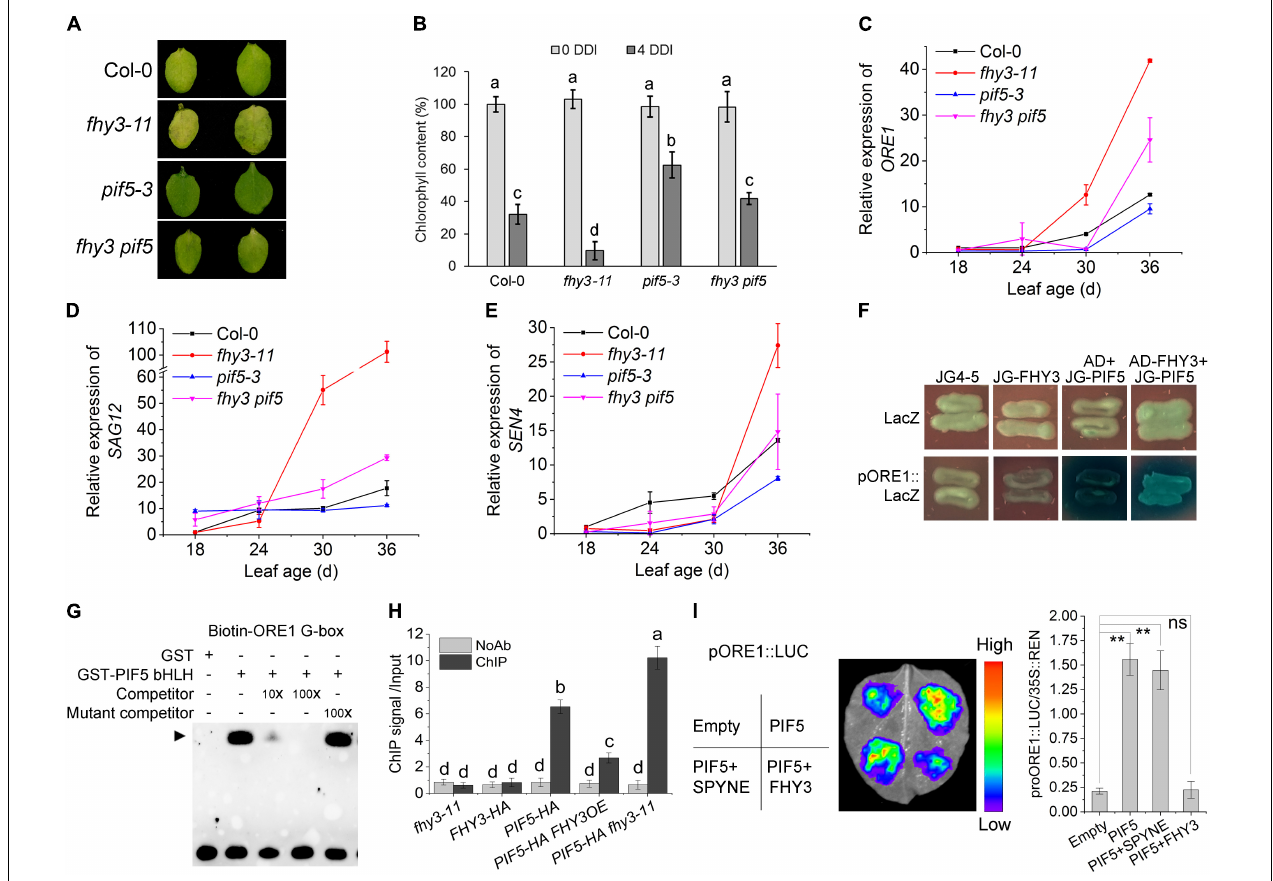
FIGURE 5 | FHY3/FAR1 represses the transcriptional activity of PIF5. (A) The senescence phenotypes of the detached leaves of 4-week-old Col-0, pif5-3 , fhy3-11, and fhy3 pif5 plants incubated under darkness for 4 days. (B) The chlorophyll content of the fourth leaves in (A) . Error bars represent SD ( n = 6). Letters indicate significant differences by two-side LSD test ( p < 0.05). (C–E) Quantitative RT-PCR analysis of ORE1 (C) , SAG12 (D) , and SEN4 (E) expression in the fourth leaves of Col-0, fhy3-11 , pif5-3, and fhy3 pif5 at the indicated leaf age. Error bars represent SD ( n = 3). (F) Yeast one-hybrid assay shows that PIF5 binds to the ORE1 promoter and that FHY3 interferes with its binding. (G) EMSA shows that PIF5 directly binds to the G-box motif in the ORE1 promoter. (H) ChIP-qPCR assay using p35S:PIF5-HA transgenic seedlings shows that the enrichment of ORE1 promoter fragment by PIF5 was inhibited in the presence of FHY3. Leaf tissues from 4-week-old plants were harvested. Values are mean ± SD ( n = 3). Letters indicate significant differences by two-sided LSD test ( p < 0.05). (I) Transient expression assay using N. benthamiana leaves. Tobacco leaves were infiltrated with A. tumefaciens transformed with the indicated reporter and effector constructs. The relative LUC activity normalized to REN activity (LUC/REN) are shown. Error bars represent SD ( n = 3). Significant difference was identified with Student’s t -test. ns, no significance; ** p < 0.05. The pSPYNE-3 5S empty vector was used as the